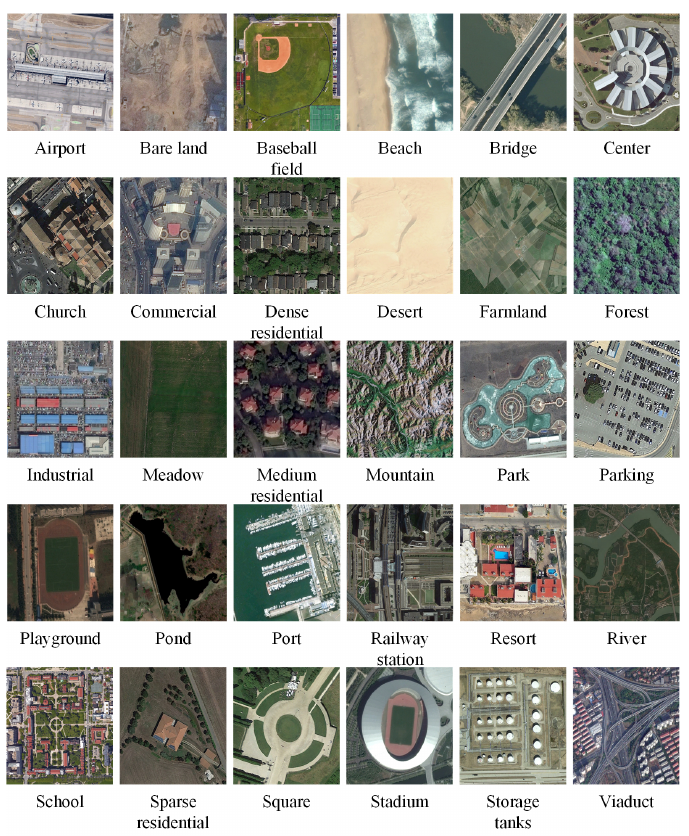
Figure 4. Examples of ground truth images of each scene category in the AID data